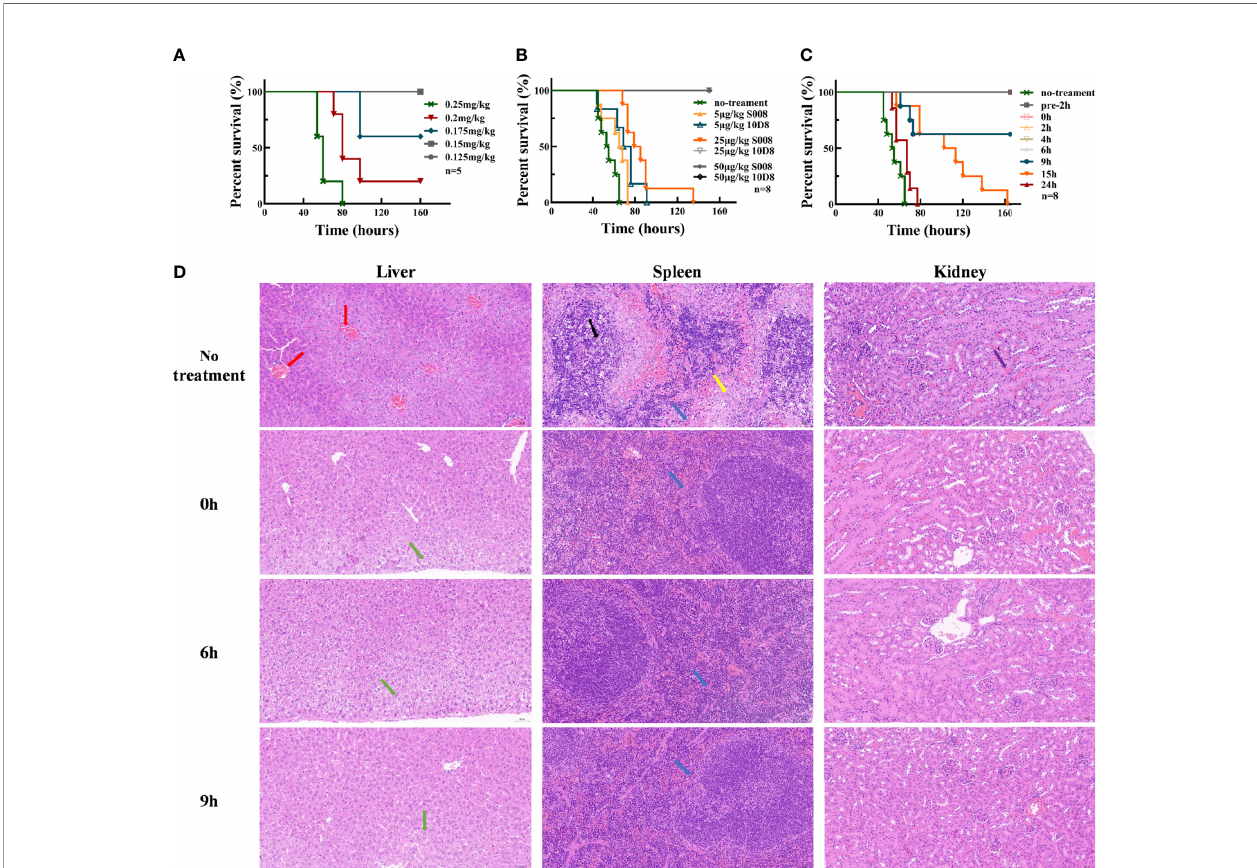
FIGURE 3 | Toxin neutralization by S008 in vivo . (A) Survival of mice intraperitoneal injected with diluted Abrin ( n =5). Survival curves drawn using GraphPad Prism version 8.2.1. (B) Survival of mice treated with diluted 10D8 or S008 antibodies after challenge with abrin at lethal dose (0.25 mg/kg) ( n =8). (C) Survival of mice administered with 0.15 mg/kg S008 before or after challenge with abrin toxin at lethal dose (0.25 mg/kg) ( n =8). Post-administration of S008, -2, 0, 2, 4, 6, 9, 15, 24 h time points after abrin injection are noted. When S008 was administered earlier no more than 6 h, mice survived; (D) HE-staining of tissues in surviving mice administered 0.15 mg/kg S008 at different time points after abrin injection. Samples were compared with that of mice in the untreated group. From top to bottom: un-treated toxic, 0 h, 6 h and 9 h groups; The left vertical row shows staining of liver, the middle row shows spleen, and the right row shows kidneys. In the no treatment group, venous congestion and dilation (red arrow) were observed in liver, while slight granular degeneration (green arrow) were observed in liver tissue in S008-treated groups, which was normal; meanwhile, there was more desmoplasia (yellow arrow) around the splenic nodules, and more lymphocyte apoptosis and nuclear fragmentation could be seen contrasting to treatment groups (black arrow). There was a small amount of neutrophil in fi ltration (blue arrow) in all groups; Ecchymosis (purple arrow) in the renal cortex and medulla could be seen in toxic but not in antibody treated mice. Magni fi cation is